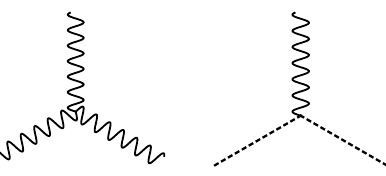
Figure 12. The pure gauge vertex, and the mixed gauge-fermion vertex coming from the minimal coupling